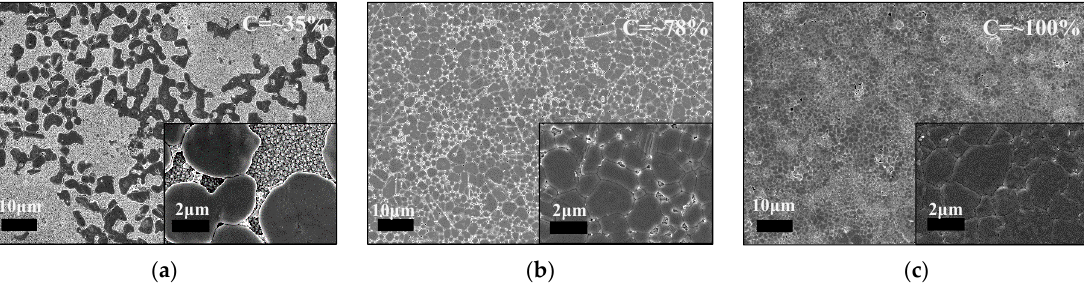
Figure 9. SEM images of spray-on perovskite films deposited on FTO-coated glass substrates at substrate temperatures of 150 °C. The number of spray passes are ( a ) 40; ( b ) 70; and ( c ) 100. Letter C refers to the percentage of coverage of perovskite layer on the substrates.